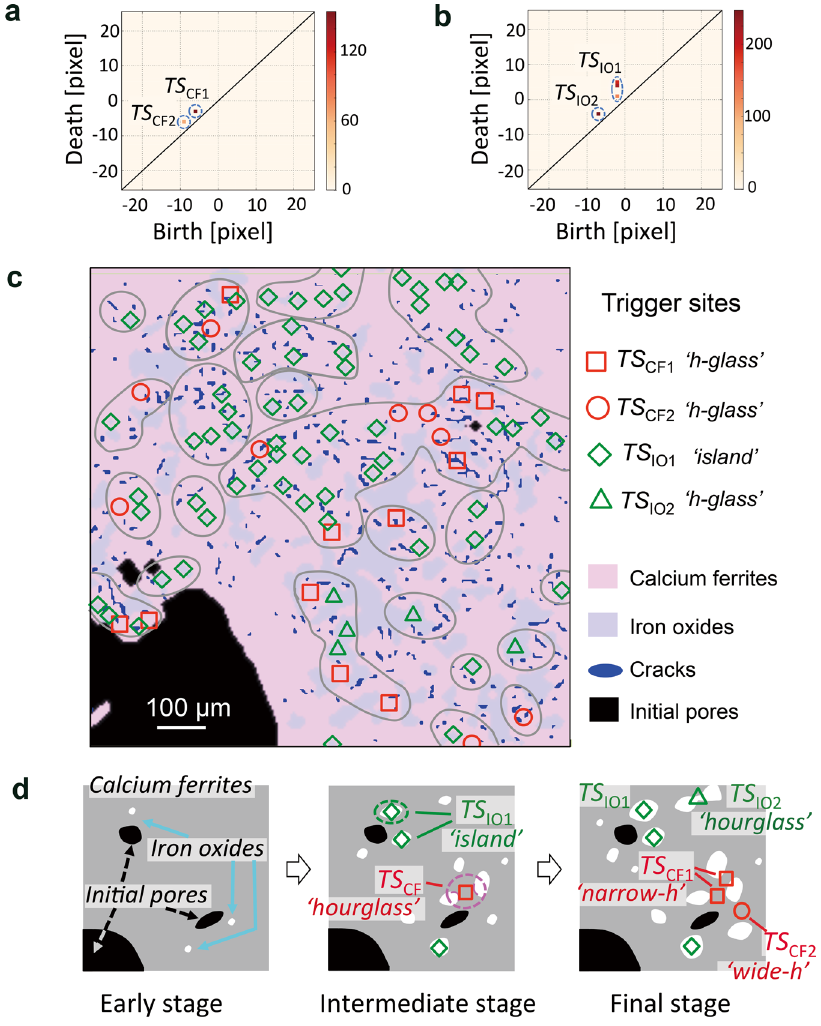
Figure 4. Results of the LASSO analysis and identified trigger sites. ( a , b ) Results of the LASSO analysis for the calcium ferrites and iron oxides, respectively. ( c ) Trigger sites in the calcium ferrites ( TS CF1 and TS CF2 ) and iron oxides ( TS IO1 and TS IO2 ), corresponding to the topological features in Fig. 4a and b, respectively, which are highly correlated with crack formation. The pink and blue matrix-regions represent the calcium ferrite and iron oxides phases, respectively. The black and blue ones show the initial pores and the cracks formed during reduction. ( d ) Schematic of the reduction process and the trigger sites employed: ‘hourglass’-shaped features of calcium ferrites ( TS CF ) and ‘island’- and ‘hourglass’-shaped features of iron oxides ( TS IO